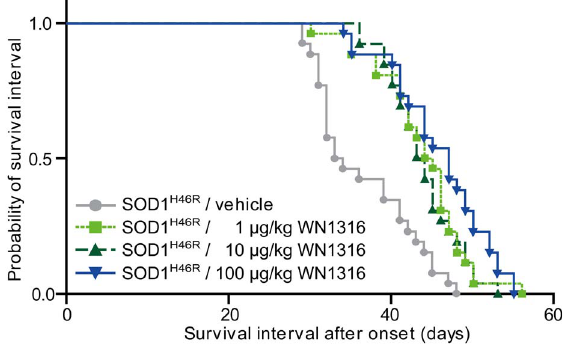
Figure 8. The WN1316 treatment prolongs the survival interval after onset in ALS(SOD1 H46R ) mice. The Kaplan-Meier curves demonstrate the probability of survival interval of vehicle control and WN1316 (1 m g/kg, 10 m g/kg and 100 m g/kg)-treated ALS(SOD1 H46R ) mice. The average onset of ALS(SOD1 H46R ) mice was 125.1 6 2.4 days (n=104). Survival intervals in WN1316-treated groups at doses of 1 m g/ in vehicle group (36.6 6 6.2 days, n=26) ( p , 0.05 by log-rank test). These data are expressed as mean 6